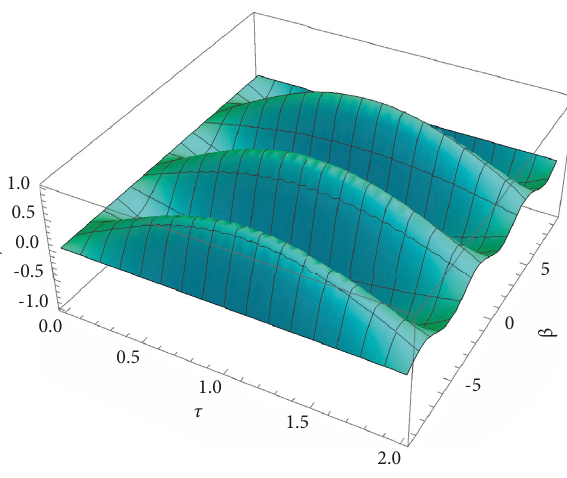
Figure 19: The real part of the exact solution to Example 2.